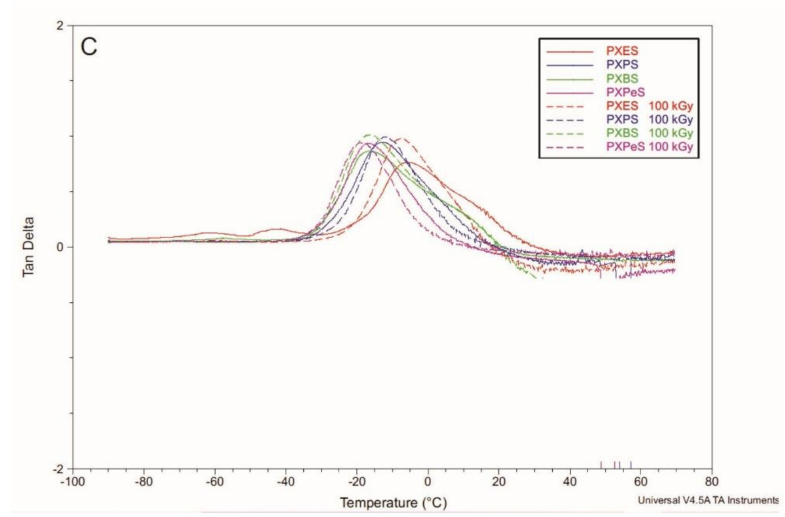
Figure 11. ( A ) E (cid:48) (storage modulus), ( B ) E (cid:48)(cid:48) (loss modulus), and ( C ) loss tangent tested by DMTA for PXES, PXPS, PXBS, and